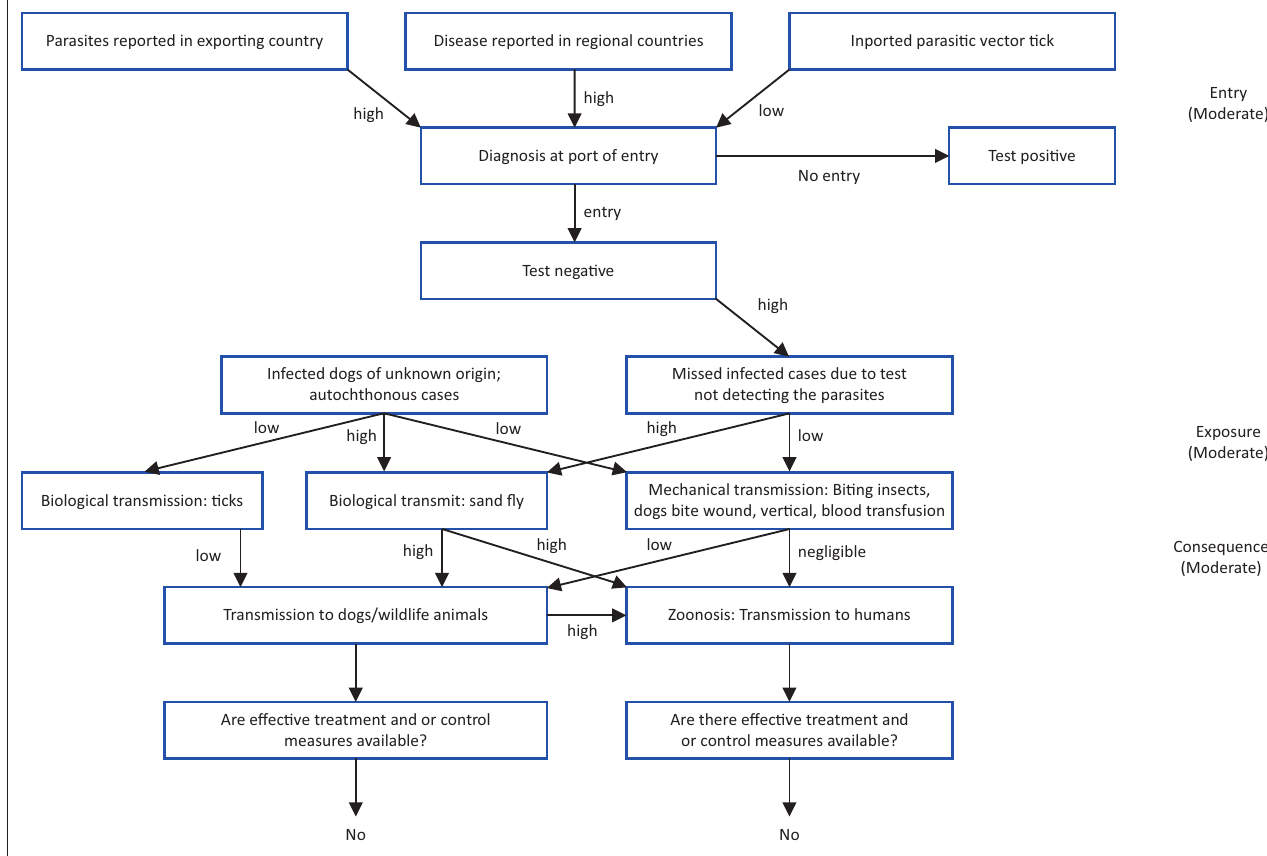
FIGURE 3: Risk pathway and probability (negligible to high) for entry (release), exposure and consequence assessment for introduction of canine leishmaniasis. TABLE 3: Degree of uncertainty in the quality and availability of data and scientific evidence in relation to qualitative risk assessment. Uncertainty Category